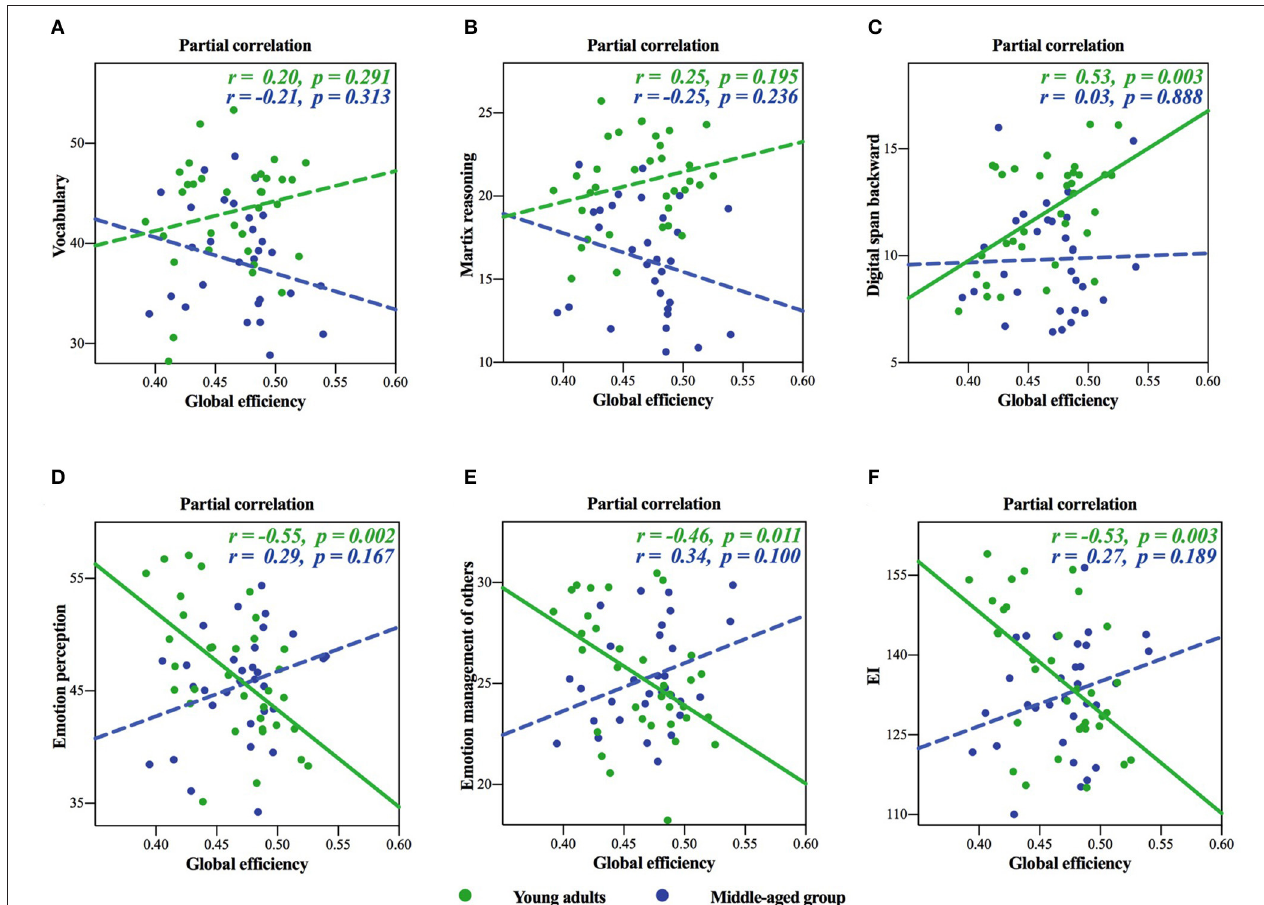
FIGURE 2 | Inverted age × global efficiency interactions of the surface area network in cognitive intelligence and emotional intelligence (EI). (A – C) showed cognitive intelligence, and (D – F) showed EI. The solid lines represented the statistically significant subgroup correlations, whereas the dashed lines represented the subgroup correlations that did not pass the significance test or the false discovery rate (FDR)